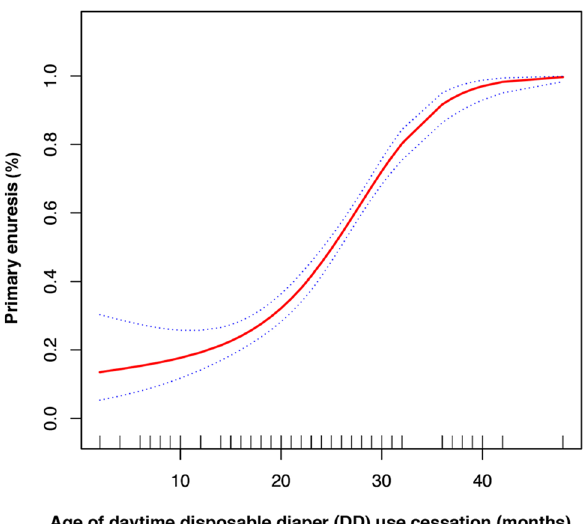
Figure 1. Association between the age of disposable diaper use cessation and primary enuresis (%). A nonlinear relationship between them was detected after adjusting for age (years), mother’s education (years), residence, UTI, constipation, anaphylactic disease and family history.